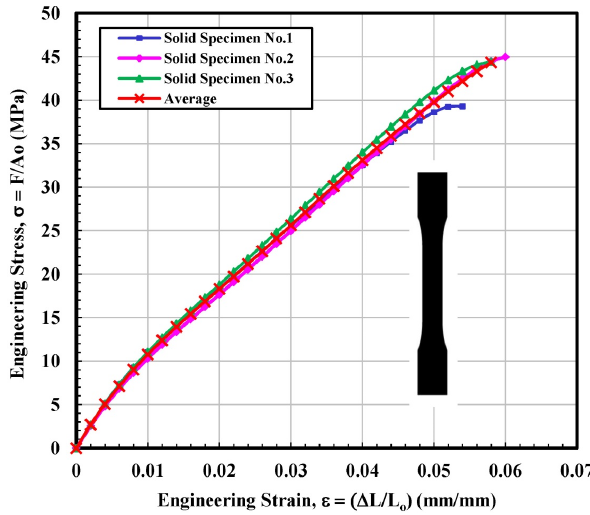
Figure 5. Engineering stress–strain curves for solid tested specimens. Table 1. Experimental results of mechanical properties for solid tested